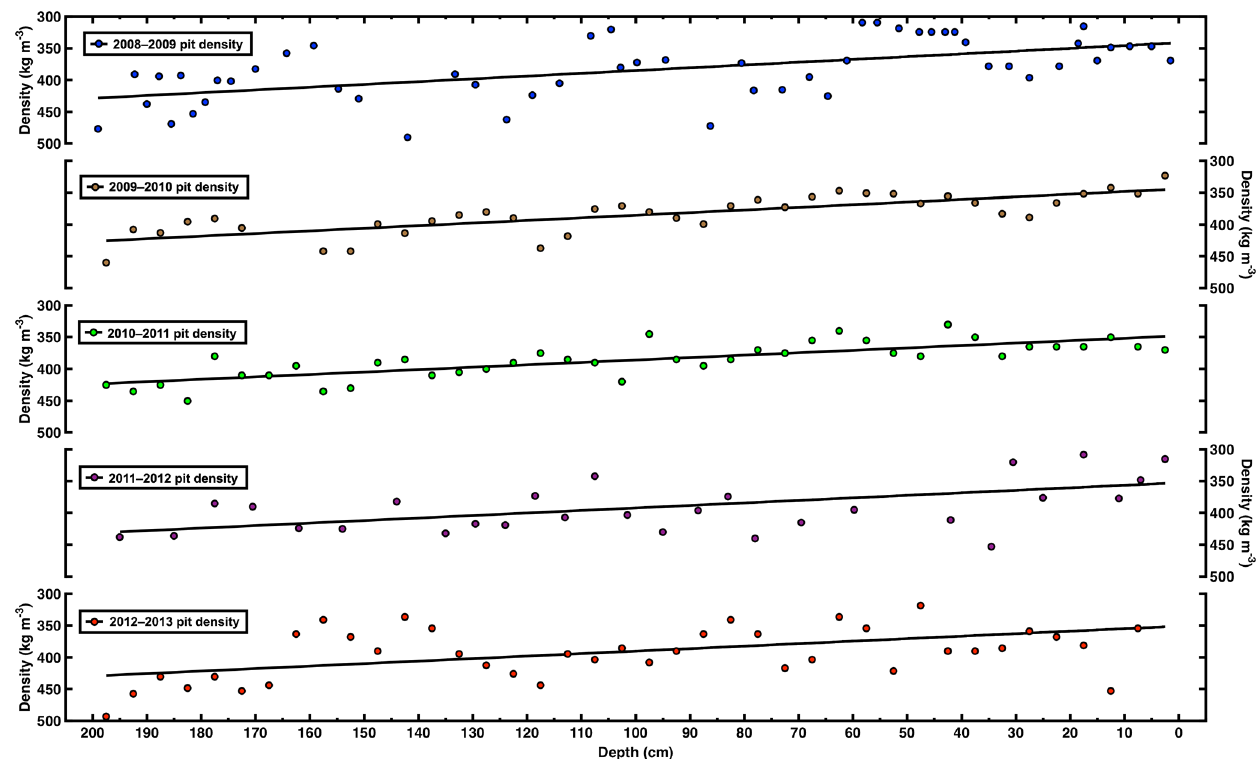
Figure 14. Density profiles measured in snow pits from five concurrent seasons at WAIS Divide (2008–2012). Each pit showed a high degree of sample-to-sample variability as measured densities were widely spaced within the upper 2m of snow; estimated annual signals were still identifiable, however. Measurements yielded an overall average density of 386 . 6 ± 3 . 2kgm − 3 for the upper 2m of snow across all five pits, with nearly identical linear trend-line slopes of ∼ 0 . 4kgm − 3 cm − 1 with depth.